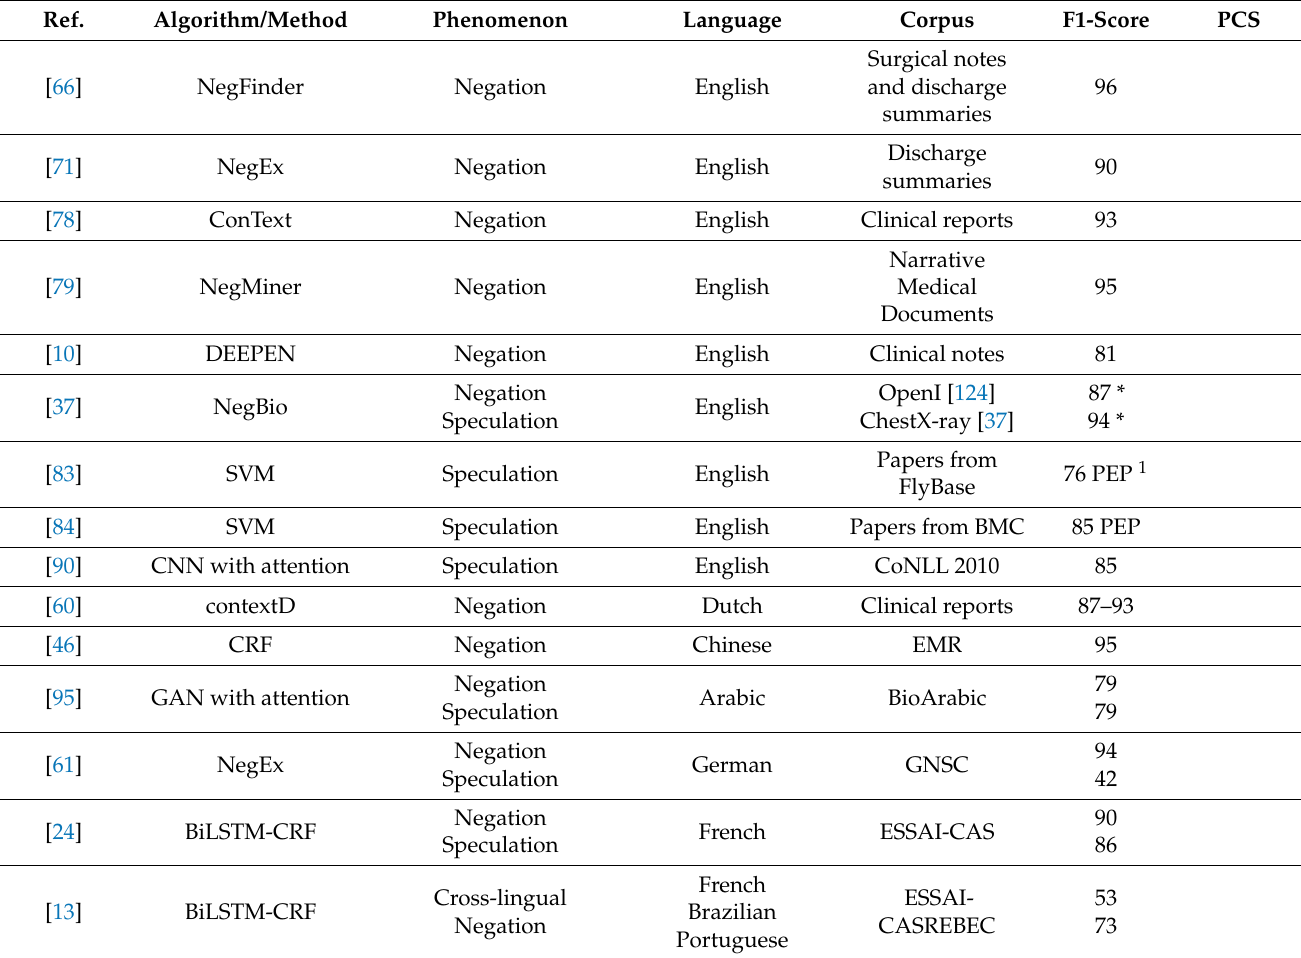
Table 5. Negation and speculation detection systems for the biomedical